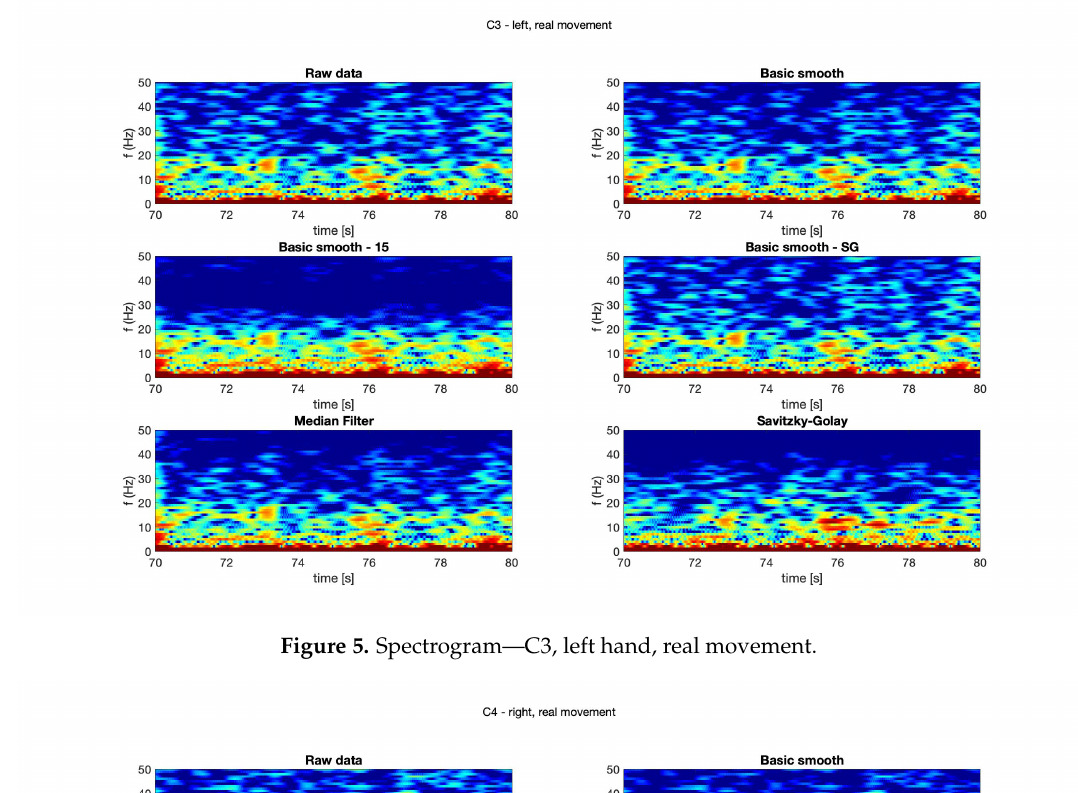
Figure 5. Spectrogram—C3, left hand, real movement.